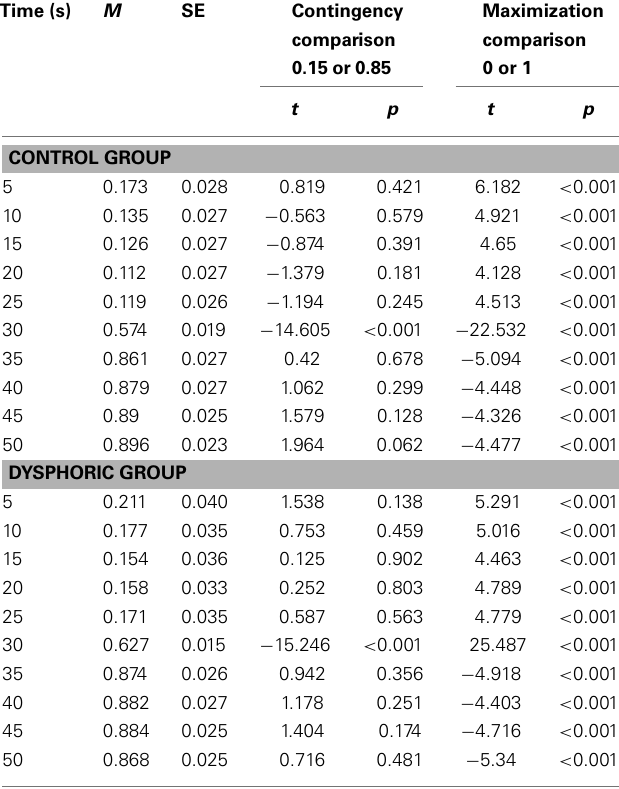
Table 2 |Absolute frequency of response for the control and dysphoric groups during each 5s time segment averaged over the early and late buttons and the 14 reinforced